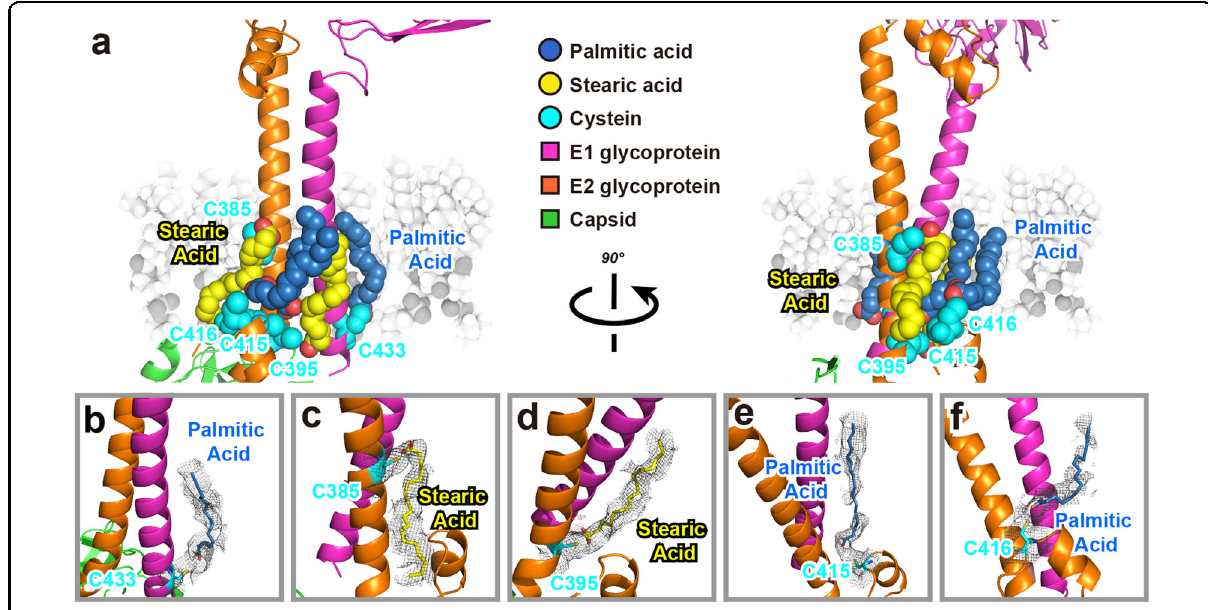
Fig. 6 S-acylation sites were identi fi ed in the E1 and E2 TM helixes and in the E2 cytoplasmic tail. a Overview of S-acylation sites of E1 and E2 proteins. E1 and E2 are presented as cartoons (in Pymol) and are colored using the same color scheme as in Fig. 2. The involved cysteines, palmitic acids, and stearic acids are presented as spheres, colored with cyan, steal blue, and yellow, respectively. The inner lea fl et of the viral envelope membrane is shown in the background. b – f Zoomed-in views of S-acylation sites. Palmitic acids and stearic acids are shown as sticks. Cryo-EM densities attributed to the cysteines, as well as palmitic acids and stearic acids, are shown as